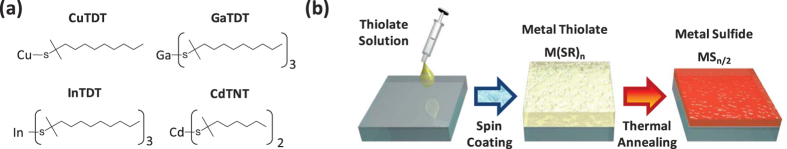
Schematic diagrams including (a) TAMT precursor molecules used to prepare sulfide films and (b) processing strategy.